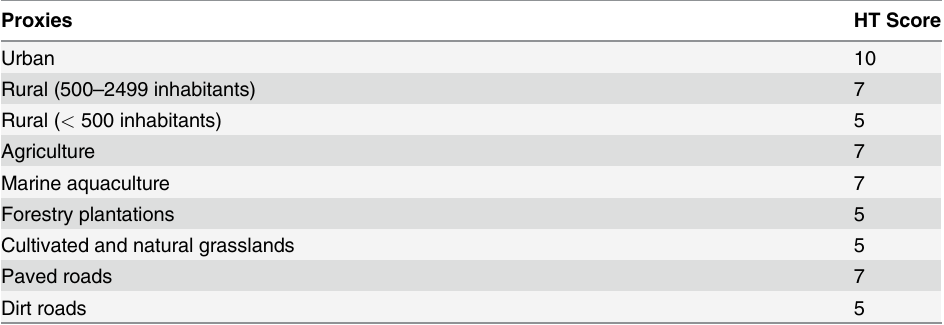
Table 1. Scores of human